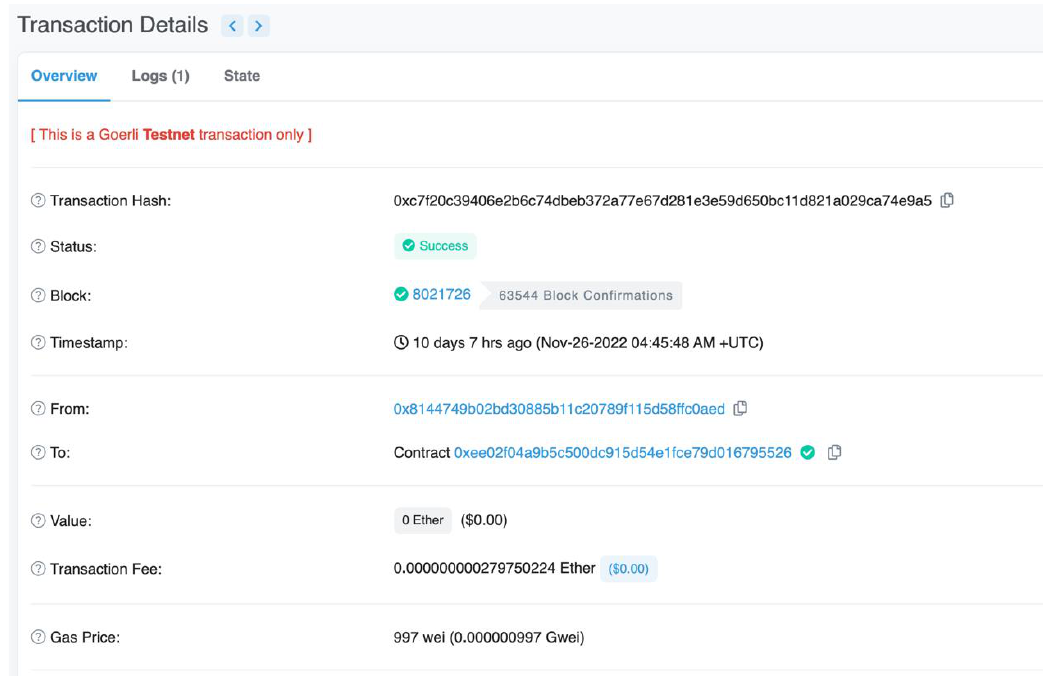
Figure A8. Proof of minting conditional token on Etherscan.